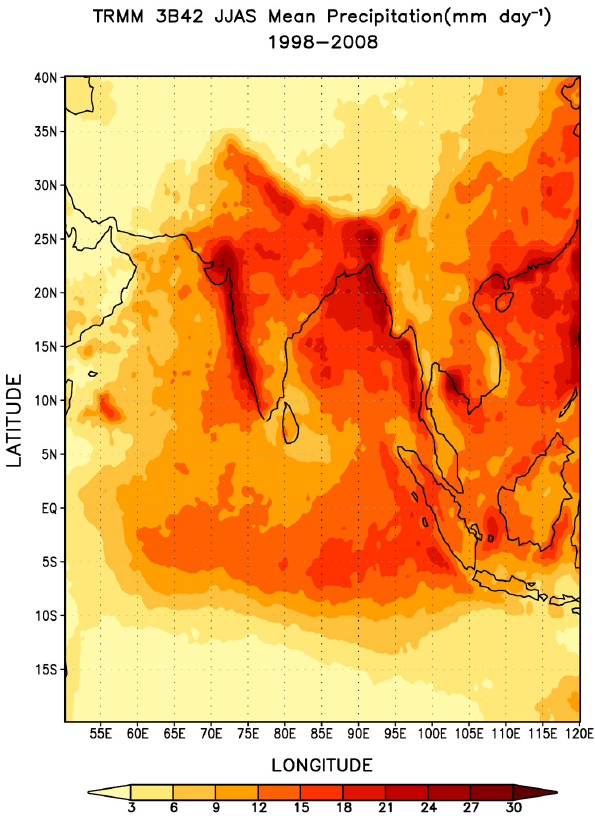
Fig. 1. TRMM 3B42 June–September (JJAS) mean precipitation (mmday − 1 ).